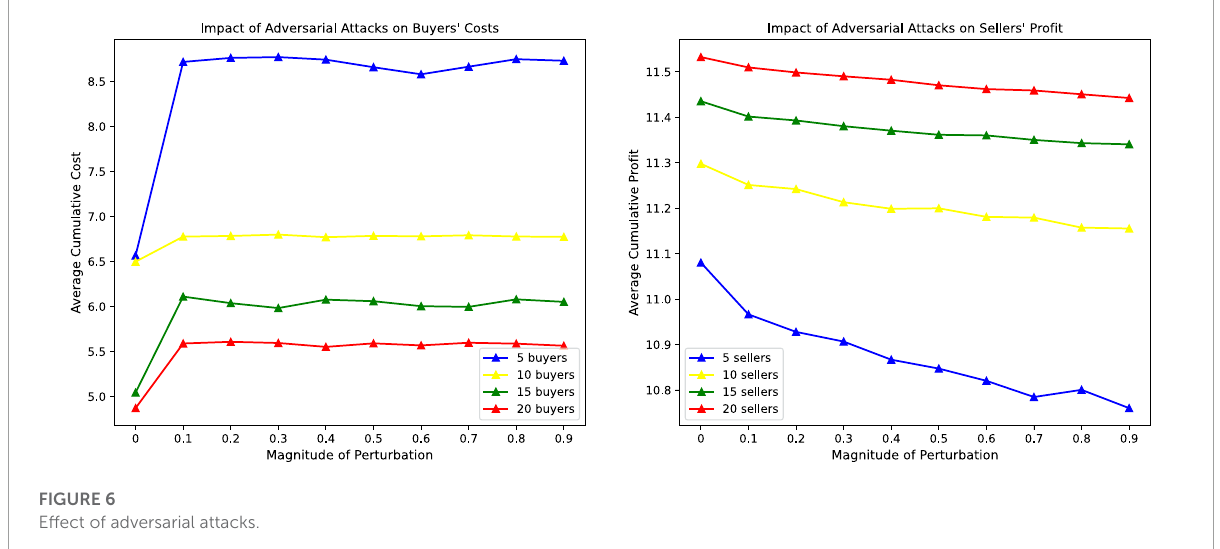
FIGURE 6 Effect of adversarial